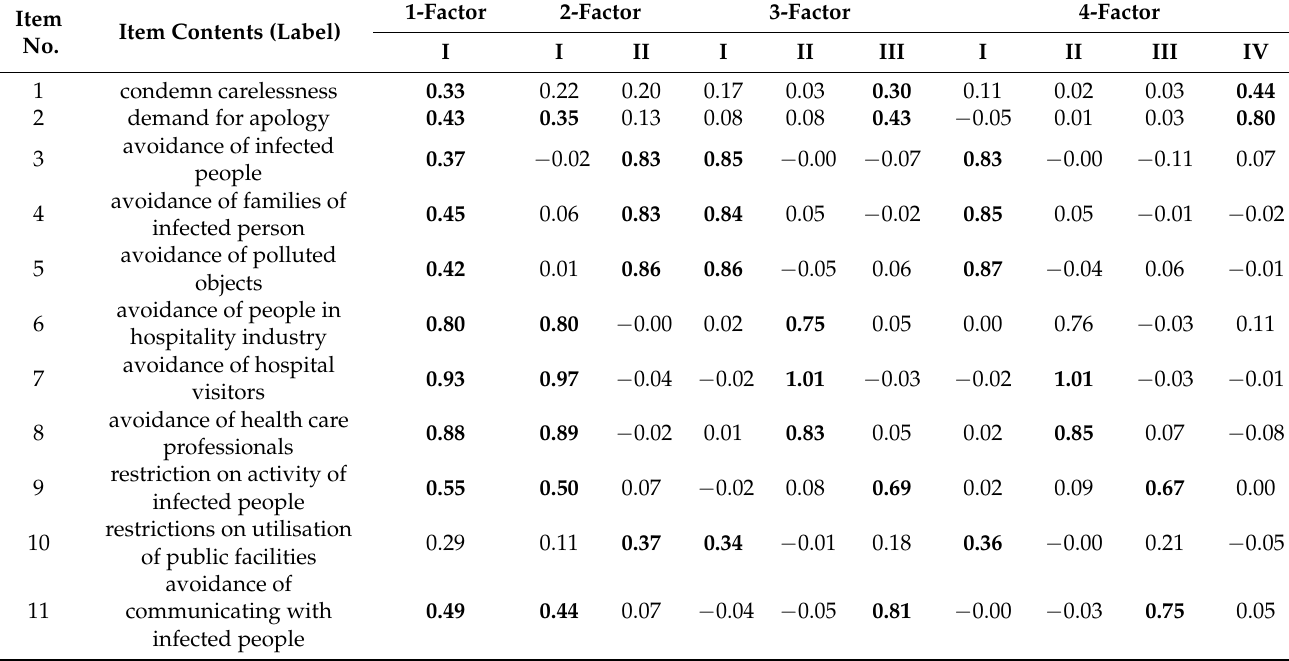
Table 3. EFA of the COVID-19 scale items ( n =